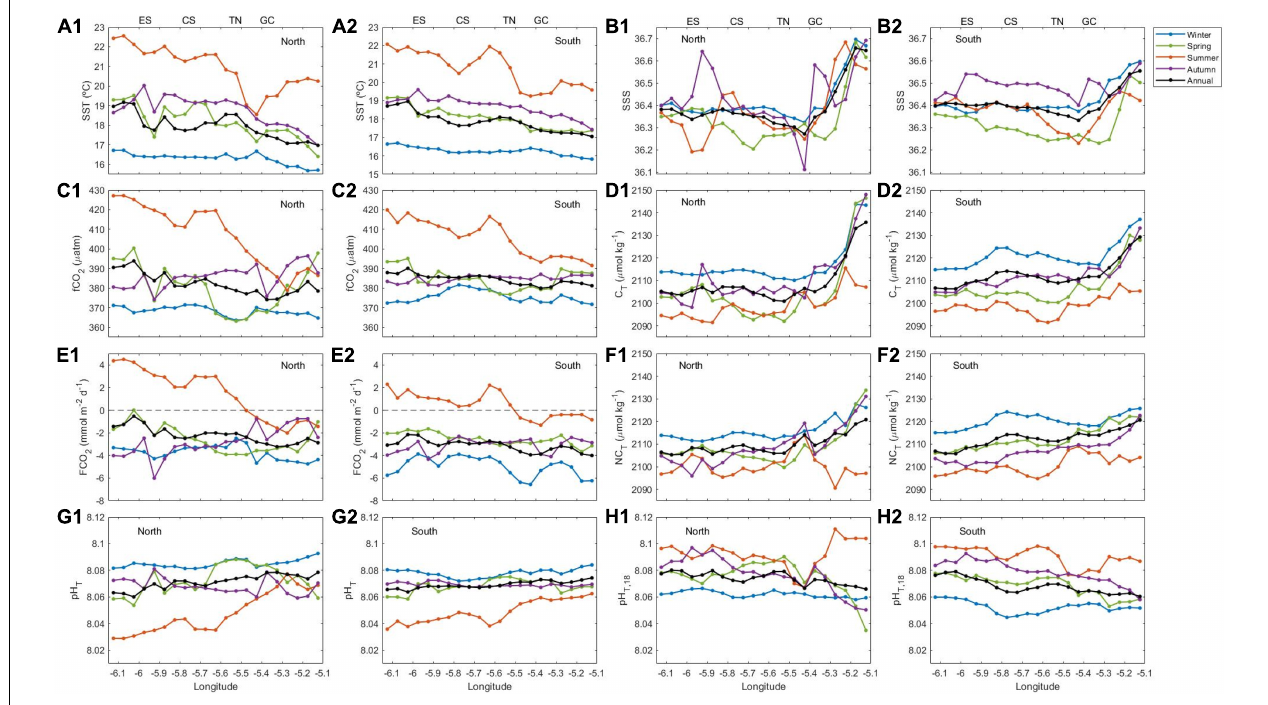
FIGURE 2 | Annual and seasonal average of (A) SST, (B) SSS, (C) f CO 2 , sw , (D) C T , (E) FCO 2 , (F) NC T , (G) pH T , and (H) pH T , 18 every 0.05 ◦ of longitude along the (1) northern and (2) southern sections in the Strait of Gibraltar.